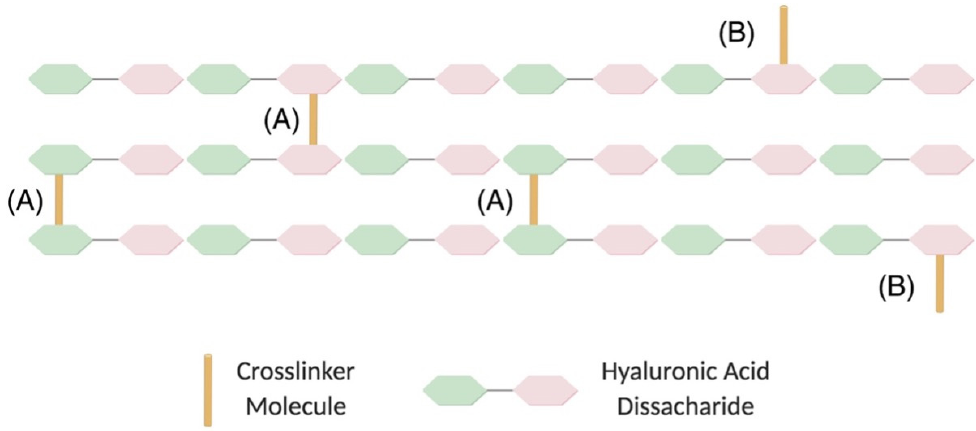
Figure 2. Diagram of HA crosslinking through (A) a crosslinker molecule linking two chains and (B) a crosslinker linked to only one chain. HA, hyaluronic acid (Reprinted from Ref. [25]).